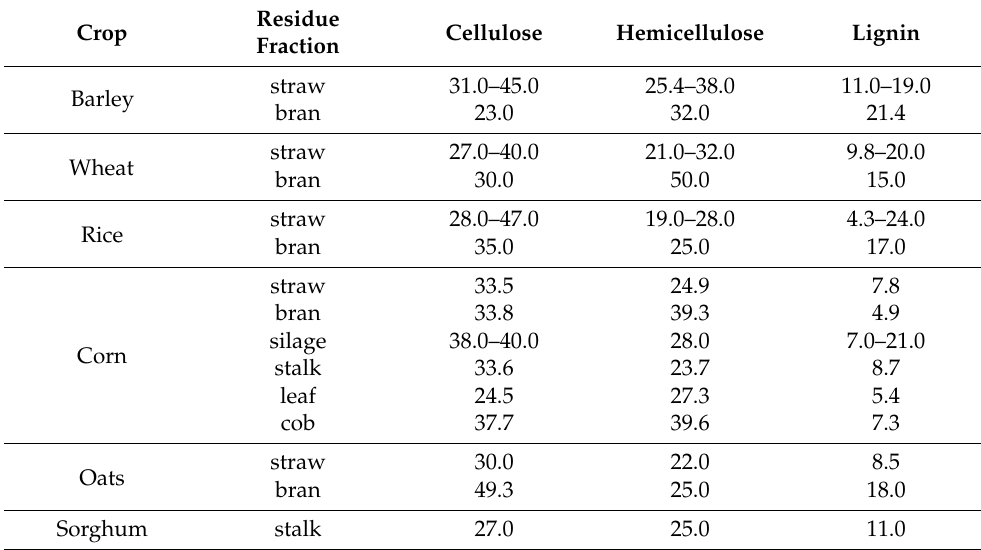
Table 2. Crop residues from plant species used for beer brewing and their cell wall components. Many of these contain cellulose, hemicellulose and lignin in concentrations similar to BSG. All values are expressed in g per 100 g dry matter (% w / w ). Table adapted from Graminha et al., 2008 [31] using data reported by Cruz 1992 [32], Prates 1995 [33], Cruz et al., 2000 [34], Couto & Sanrom á n 2005